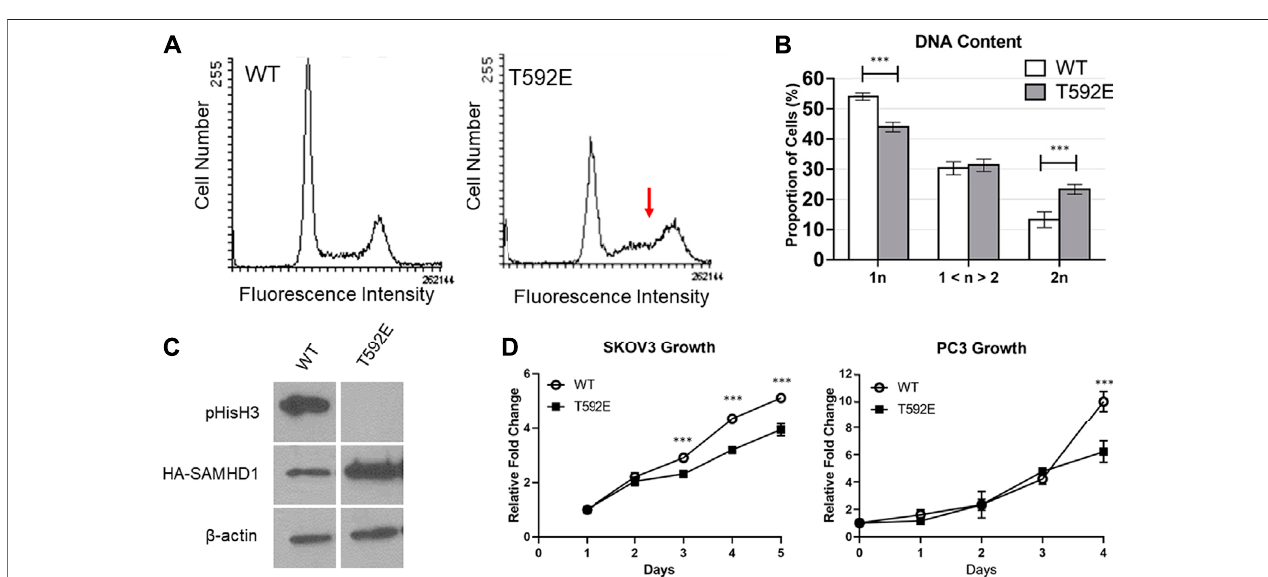
FIGURE 4 | SAMHD1 T592E affects cell cycle progression. (A) DNA histogram of PC3 cells stably expressing WT or T592E SAMHD1 (10,000 events per histogram). Cells expressing wild-type SAMHD1 show a typical cell cycle distribution. In contrast, cells expressing T592E SAMHD1 indicate an accumulation in late S-phase (red arrow). Graphs are representative of three independent experiments. (B) Quanti fi cation of DNA content by fl ow cytometry. The proportion of cells in each phase was determined by the Dean-Jett-Fox model. Graphs represent the mean of WT n (cid:1) 14 and T592E n (cid:1) 15 from three independent experiments. Error bars represent 95% con fi dence intervals. * p < 0.05, *** p < 0.001, Tukey-Kramer post-hoc test. (C) Expression of phosphorylated Histone H3 can be detected in PC3 cells stably expressing wild-type SAMHD1, but not T592E SAMHD1, suggesting fewer cells expressing T592E are undergoing mitosis. Expression of HA-SAMHD1 was probed by anti-HA antibody. Samples are from the same blot. (D) Cells stably expressing wild-type SAMHD1 grow faster than those expressing T592E SAMHD1. Relative fold change of SKOV3 cells was measured by SRB stain assay. Points represent the mean and error bars represent the standard deviation of 10 technical replicates. Relative fold change of PC3 cells was measured by counting with trypan blue. Points represent the mean and error bars represent the standard deviation of three technical replicates. * p < 0.05, *** p < 0.001, Tukey-Kramer post-hoc test.